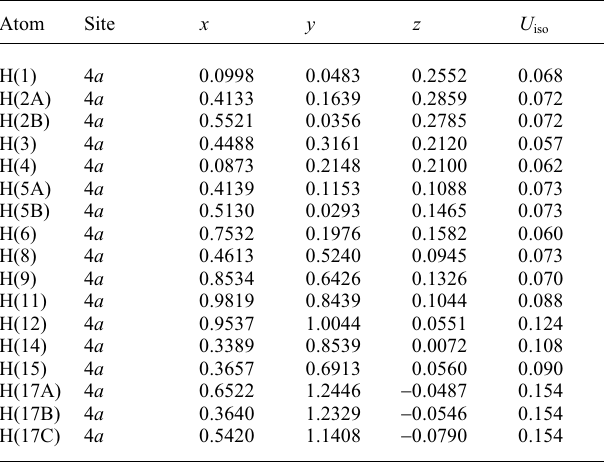
Table 2. Atomic coordinates and displacement parameters (in Å 2 )